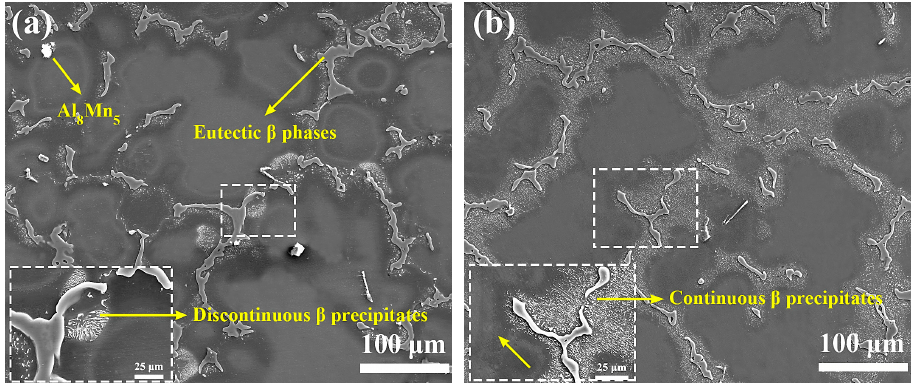
Figure 2. Scanning electron microscopy (SEM) microstructure of ( a ) as-cast AZ80 alloy and ( b ) billet reheated at 300 °C for 3 h.